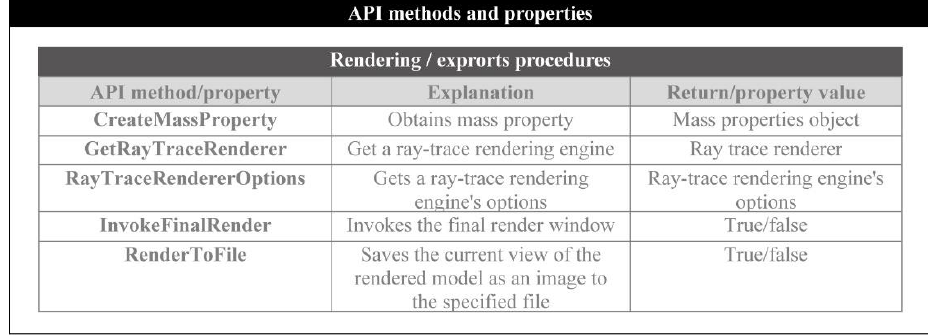
Figure 6. API methods and properties used for the rendering and the property export procedures.